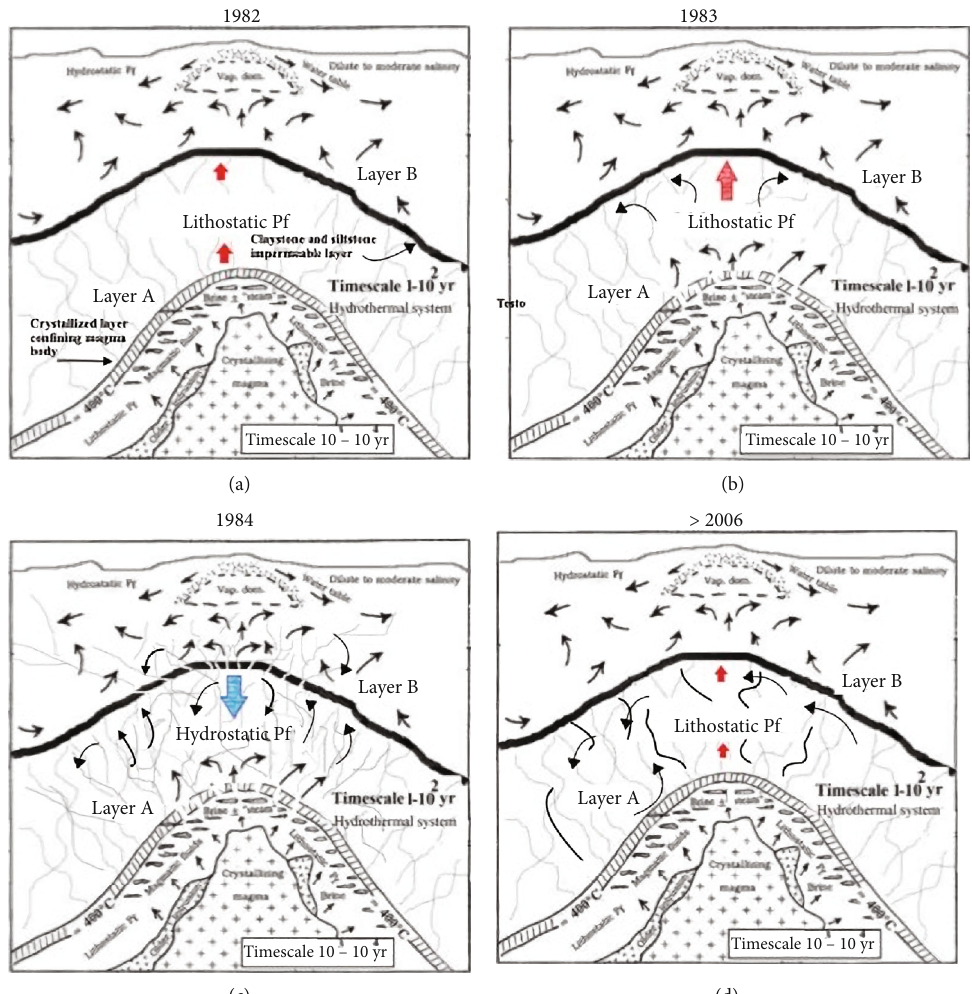
Figure 6: (a) In 1982, uplift started: long timescale magmatic system was sealed by a low permeability carapace (layer A) which blocks hot magmatic fl uids that accumulate; short timescale hydrothermal system was closed by low permeability layer (layer B). (b) In 1983, uplift continues: the carapace (layer A) breaks allowing magmatic fl uids to enter the overlying con fi ned hydrothermal system. (c) In 1984, impermeable layer B breaks as well triggering subsidence. Pressure regime changes producing faulting, brecciation, hydrothermal alteration, boiling, and silica deposition. Subsidence continues until layer B close by self-sealing. (d) Since 2006 until today, layer B is sealed, and uplift goes on (modi fi ed from Fournier